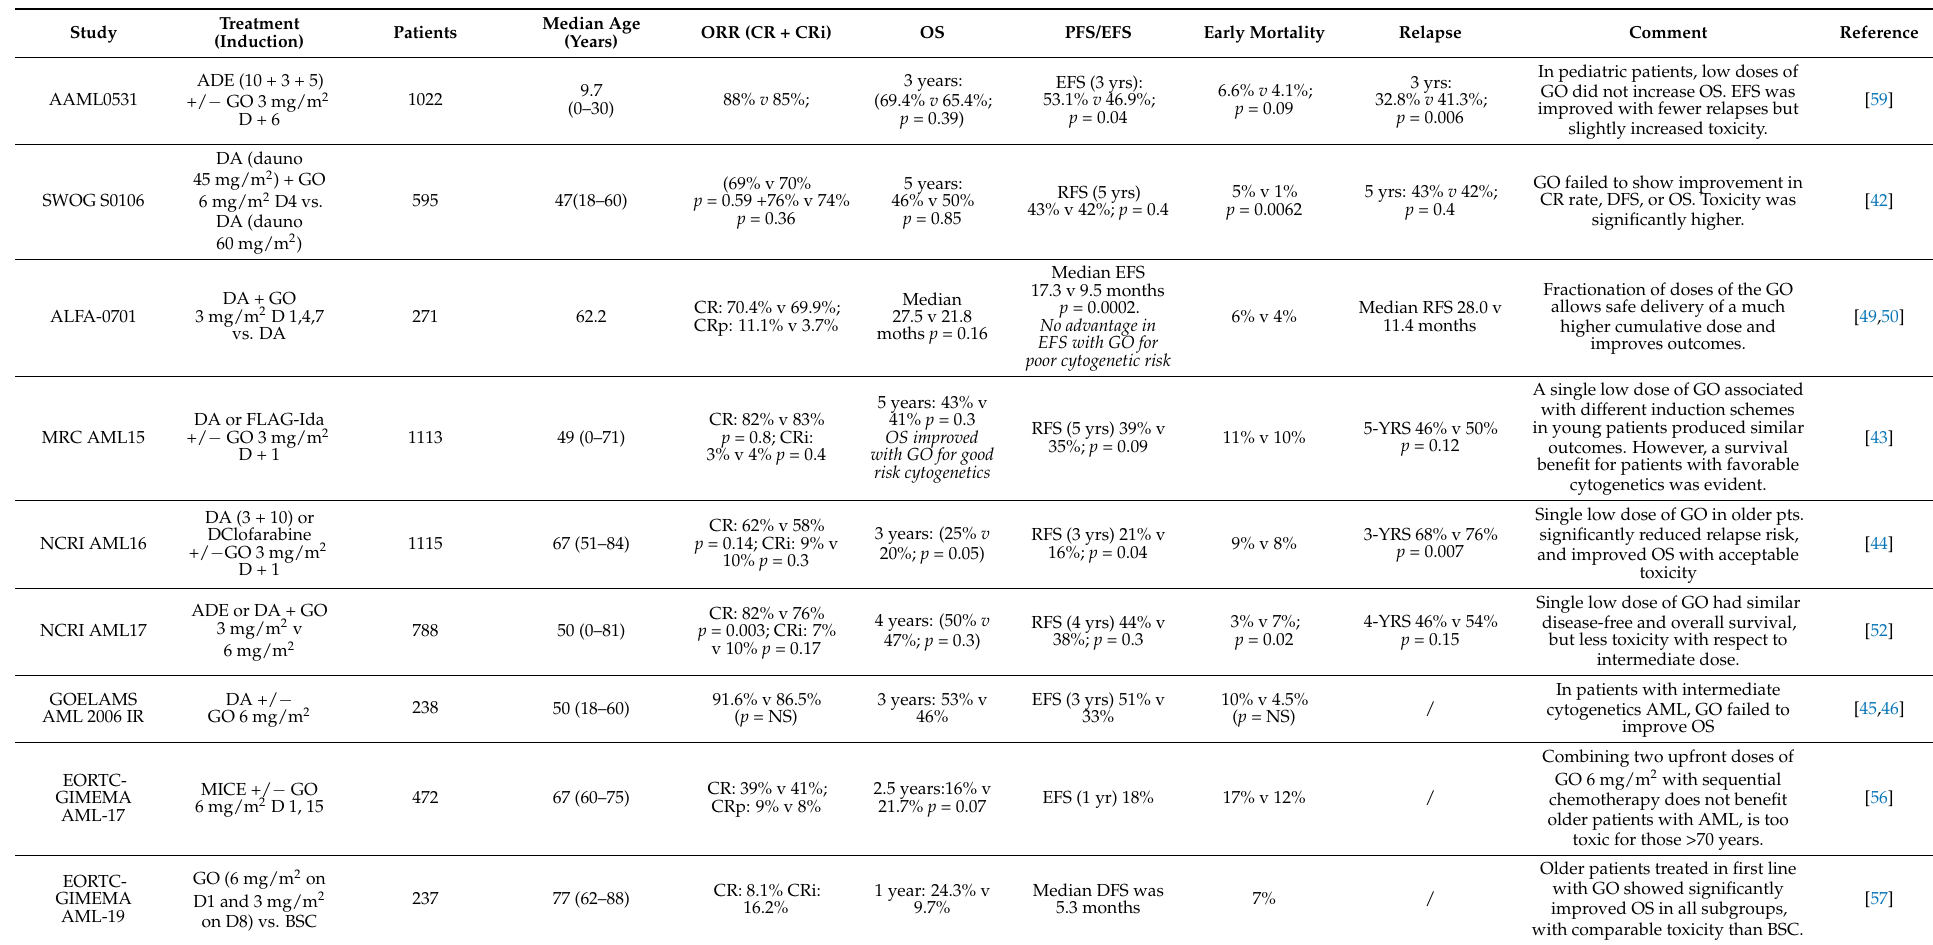
Table 1. DA: daunorubicin and cytarabine; ADE: Ara-C, daunorubicin, and etoposide; FLAG-Ida: fludarabine, cytarabine, granulocyte colony-stimulating factor, and idarubicin; MICE: mitoxantrone 7mg/m 2 D1, 3, 5; etoposide 100mg/m 2 D1–3; and cytarabine 100mg/m 2 D1–7; BSC: best supportive